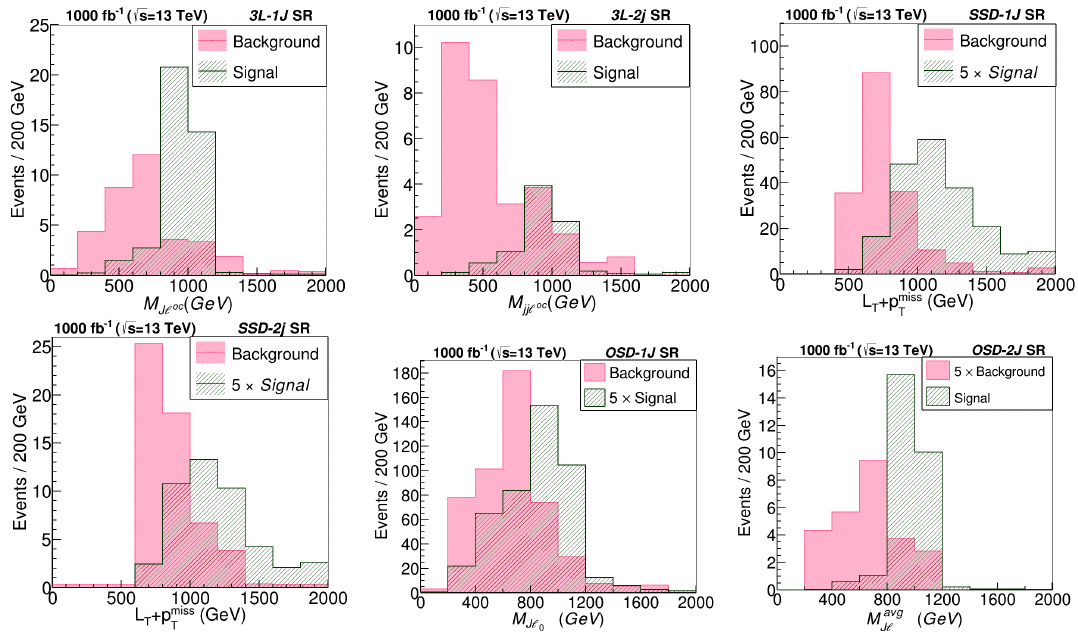
Figure 9 . Distributions of the primary kinematic discriminants for all the SRs for BP1 : M χ = 1 TeV and BR ( χ ± → νW ± ) ≈ 50% in Model- 3 F